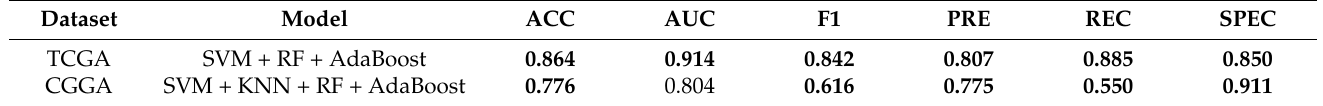
Table 6. The computational results without the feature selection process for the best ensemble